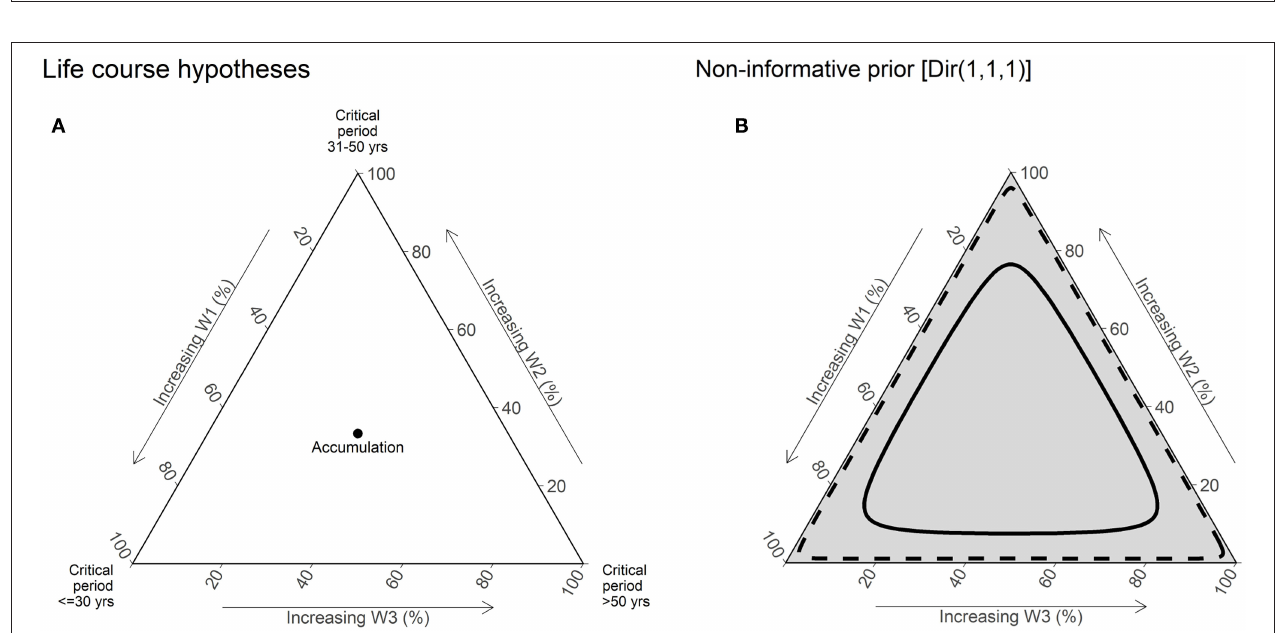
FIGURE 1 | Study flowchart for the HeNCe Life Study in India and Canada.